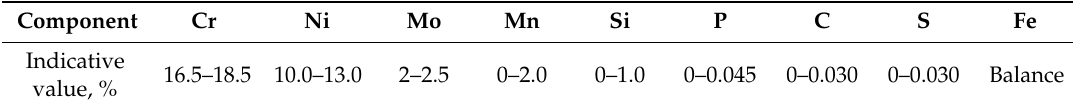
Table 1. Chemical composition of steel 316L.